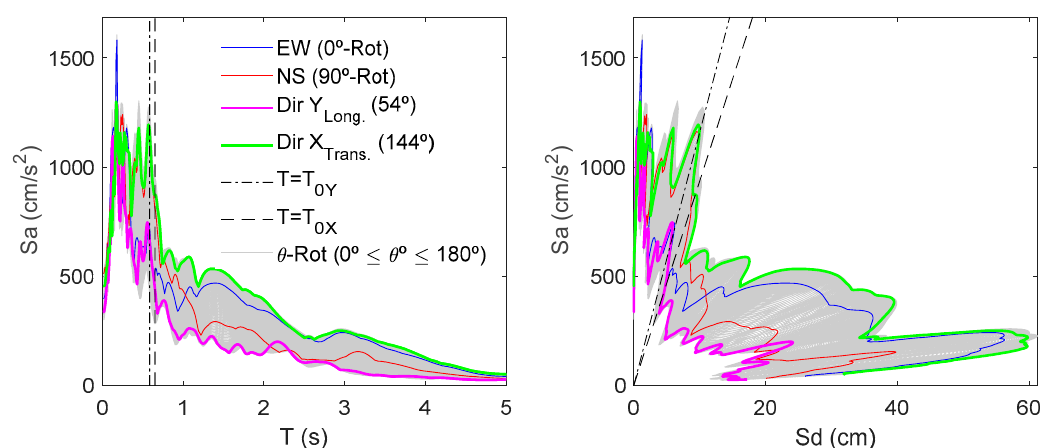
Figure 16. The 5% damped response spectra for the accelerograms obtained in the direction defined by the angle θ , from the projection of the as-recorded components EW and NS recorded at AMNT station. This figure is given in period-spectral acceleration ( T-Sa ) and in spectral displacement-spectral acceleration ( Sd-Sa ) formats. The fundamental periods of the principal axes of the building (X Trans. and Y Long. ) are also indicated.